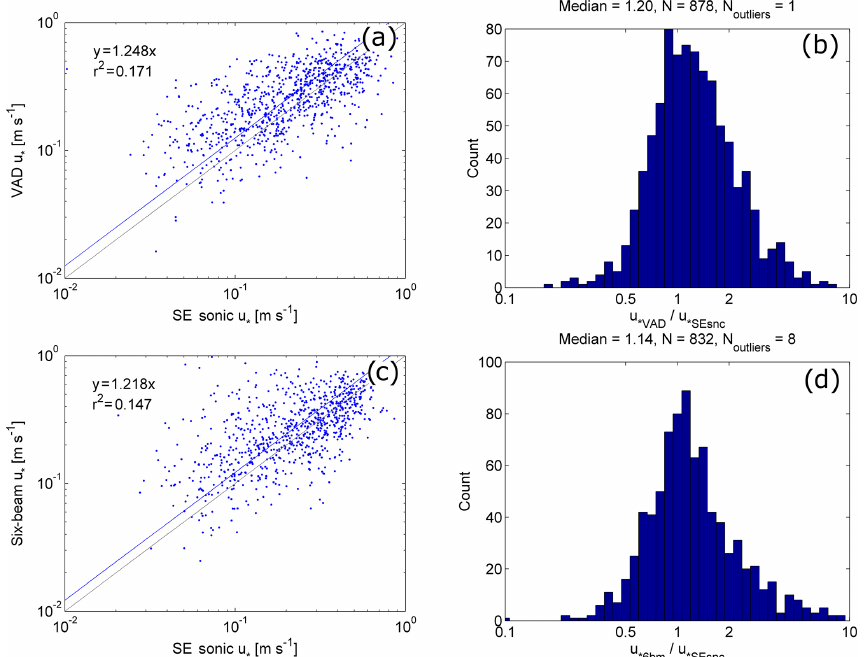
Figure 12. Same as Fig. 5 but for u ∗ instead of TKE. Lidar measurements are from TKE from two φ (a, b) and the six-beam technique (c, d)